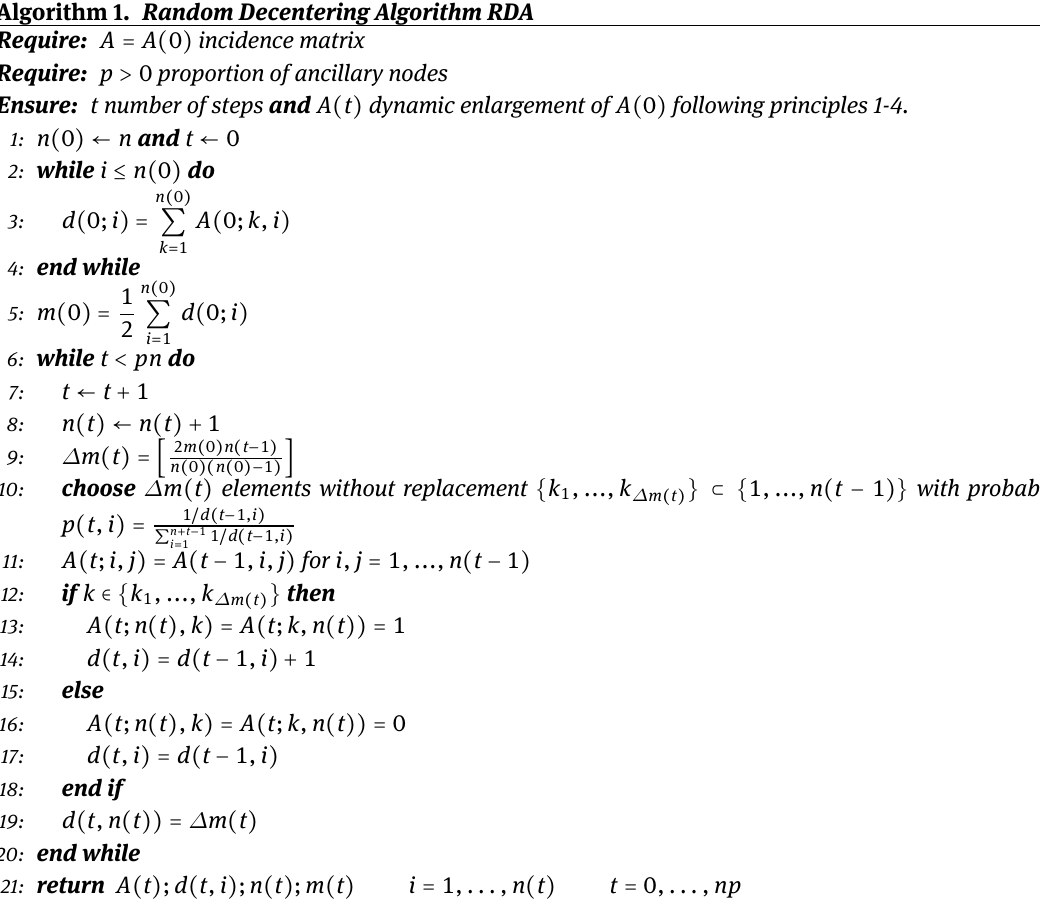
Algorithm 1. Random Decentering Algorithm